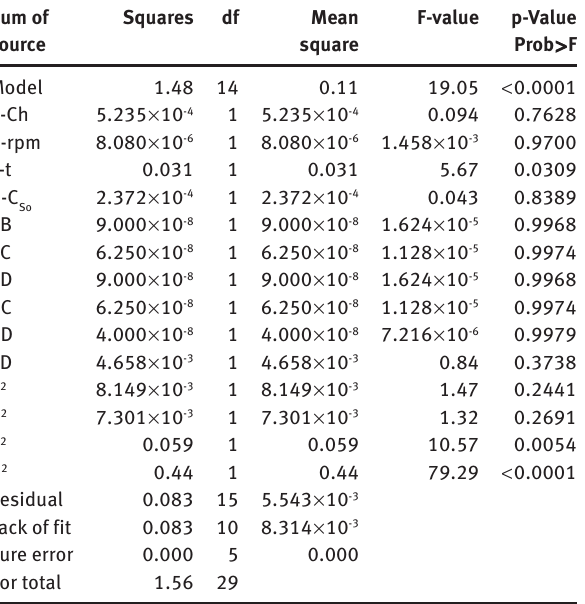
Table 4: Analysis of variance (ANOVA) for quadratic model. Sum of Squares source